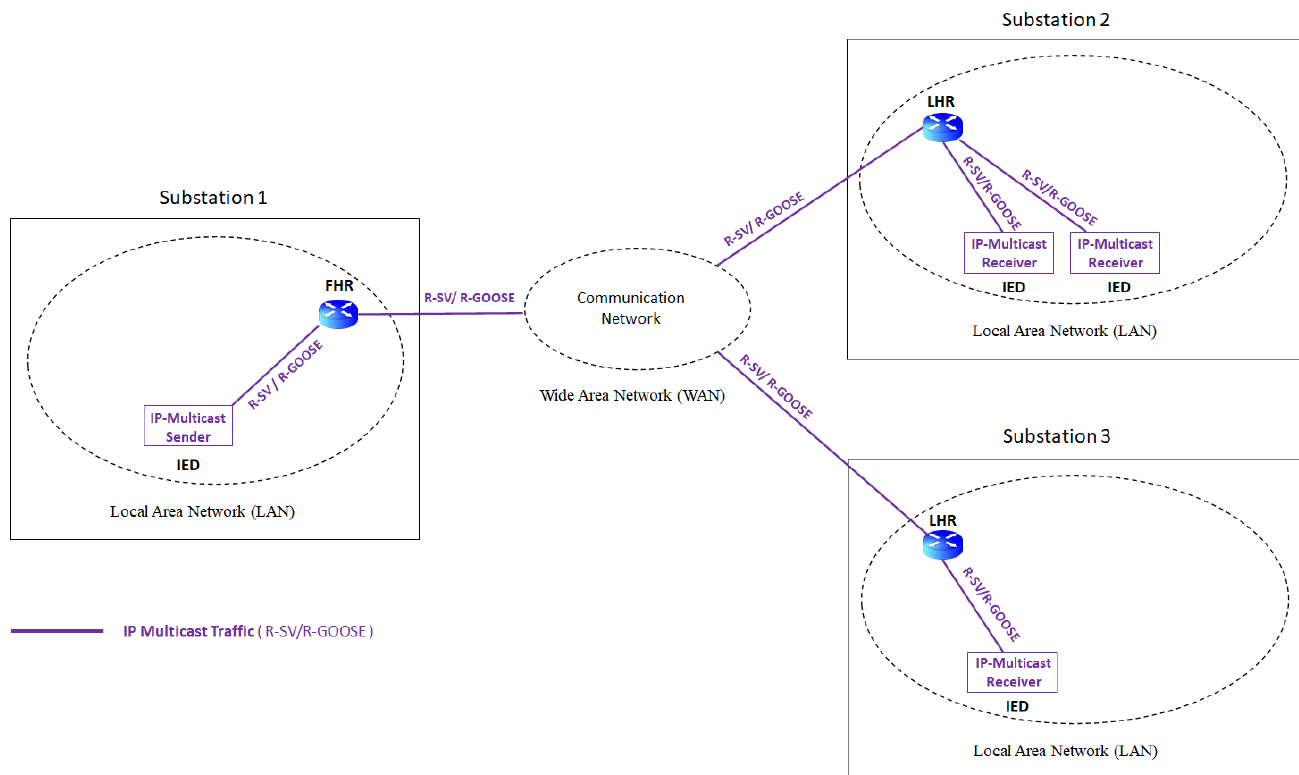
Figure 2. Multicast communication of R-SV/R-GOOSE from Substation 1 to Substation 2 and 3.